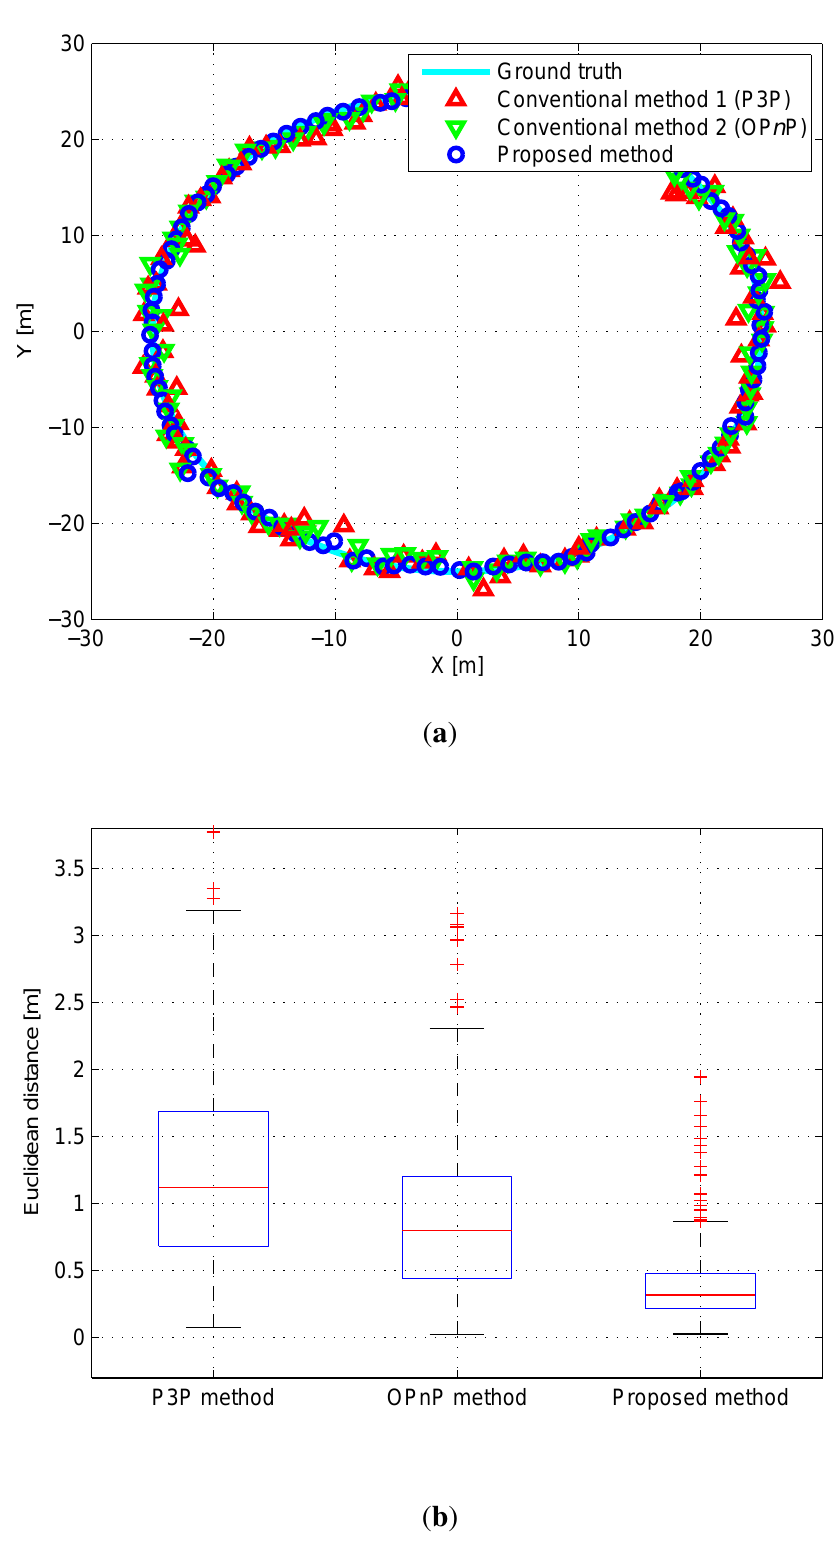
Figure 4. ( a ) Top view of the simulation results. Red triangles, green triangles, and blue circles denote results of P n P, OP n P, and the proposed algorithm, respectively; ( b ) Euclidean distance errors relative to the ground truth